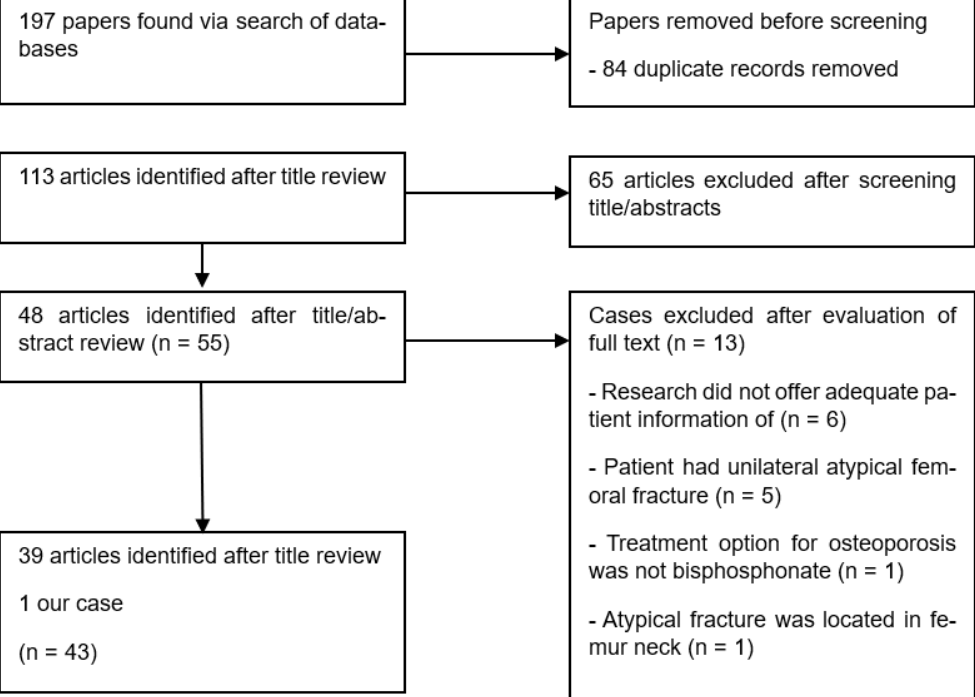
Figure 5. Flow of studies through the review.